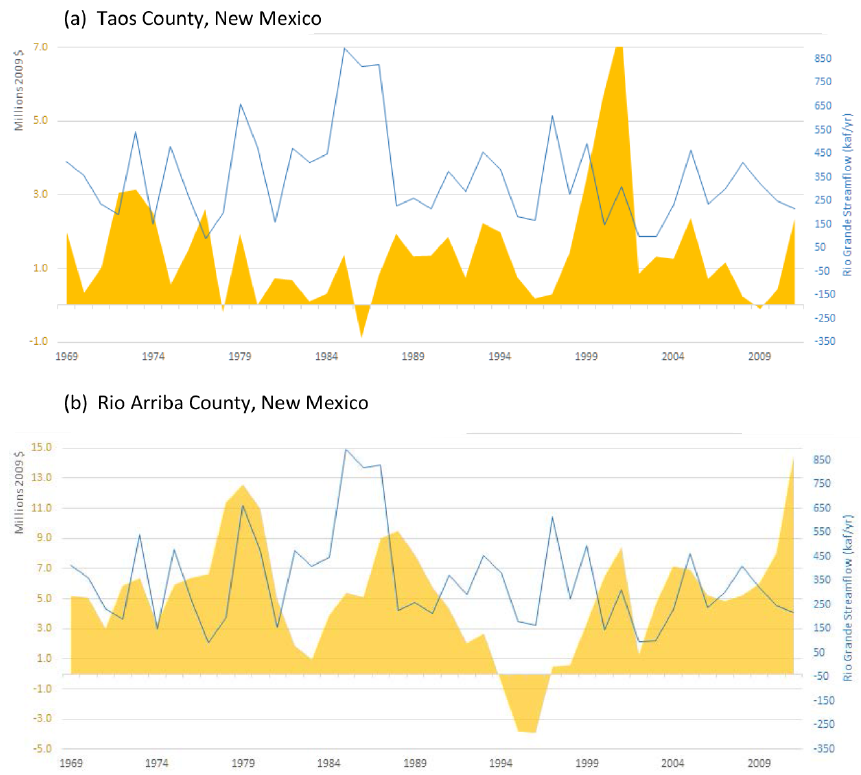
Figure 12. Trends and changes in agricultural incomes (orange areas) and streamflow (blue lines) for Taos and Rio Arriba Counties in New Mexico (US Bureau of Economic Analysis, 2013b; US Geological Survey,